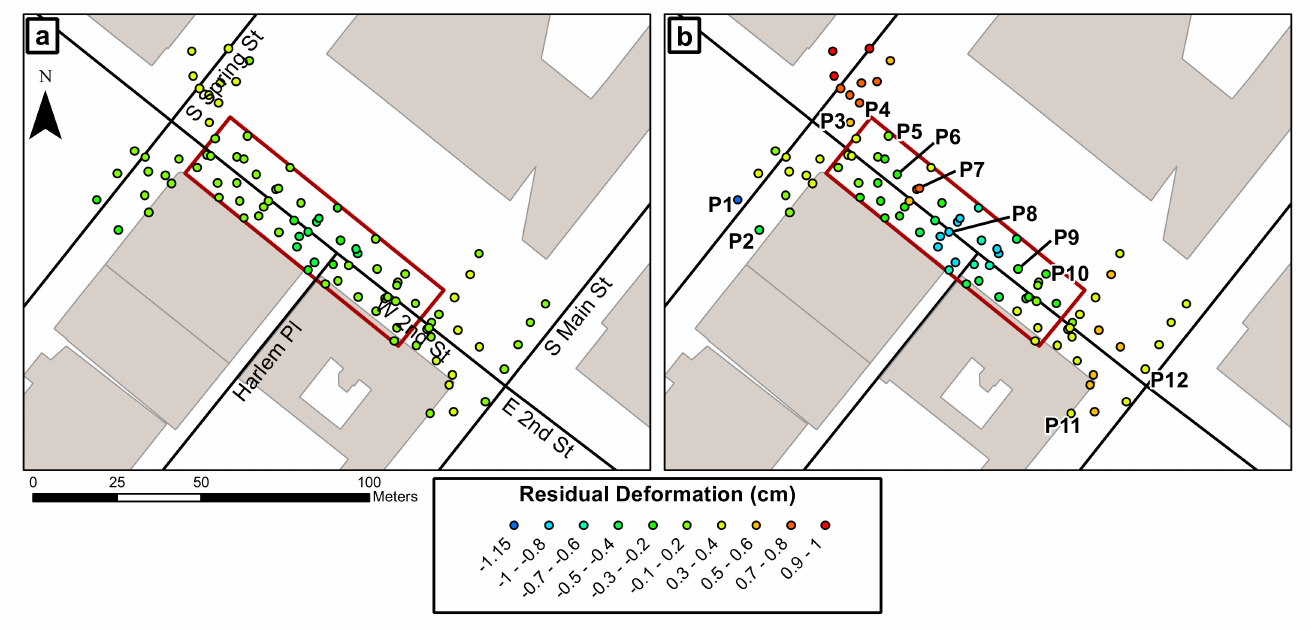
Figure 8. ( a ) Mean residual deformation ( b ) maximum residual deformation after differencing ground-based and InSAR vertical deformation data. Negative residuals, shown by cooler colors, indicate underestimation. Positive residuals, shown by warmer colors, indicate an overestimation of settlement by InSAR. Deformation time-series for points P1–P12 shown in Figure